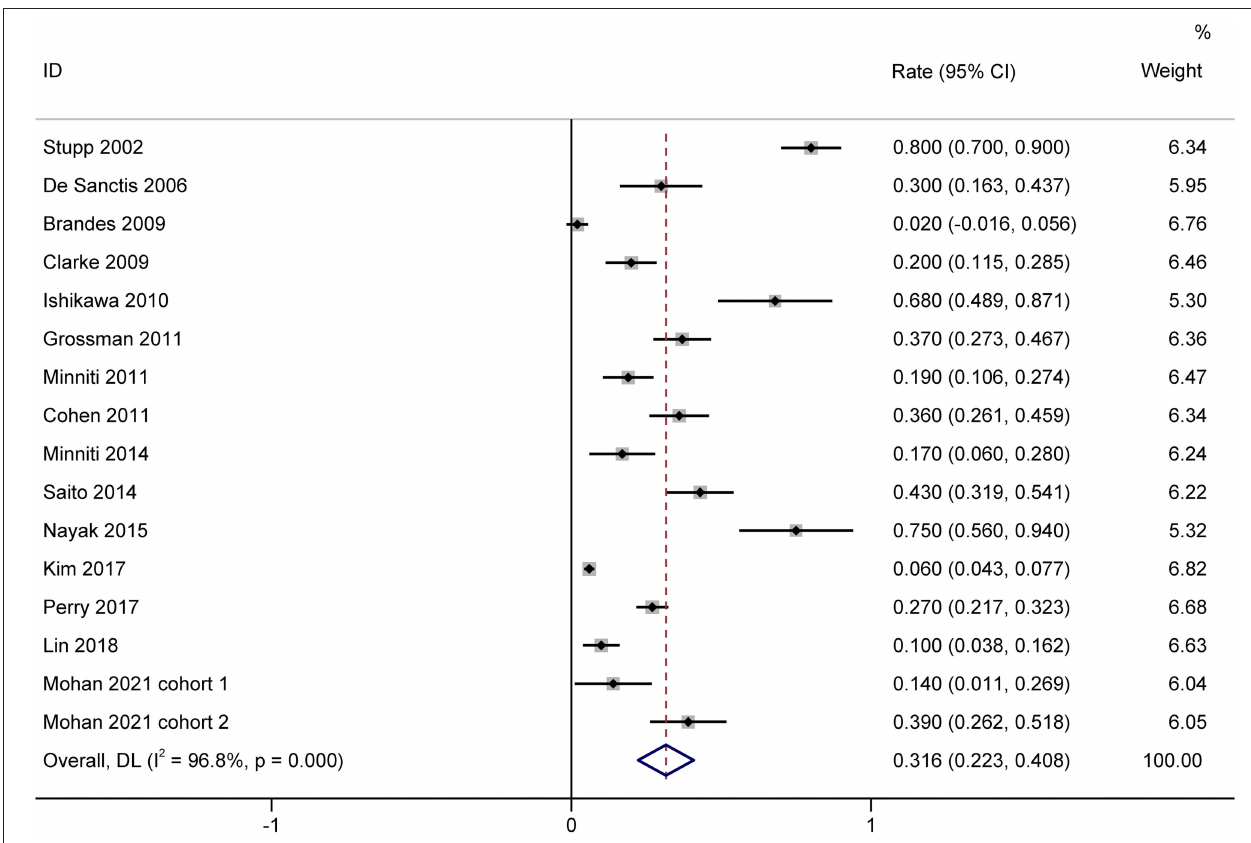
FIGURE 2 | Forest plots of the incidence rate of severe lymphopenia and 95% CIs in glioma patients. Weights are from random-effects